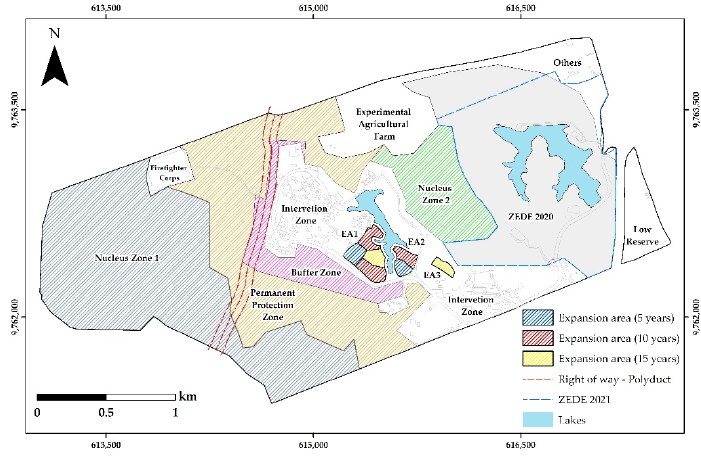
Figure 11. Location of expansion areas restricted by protected zones.